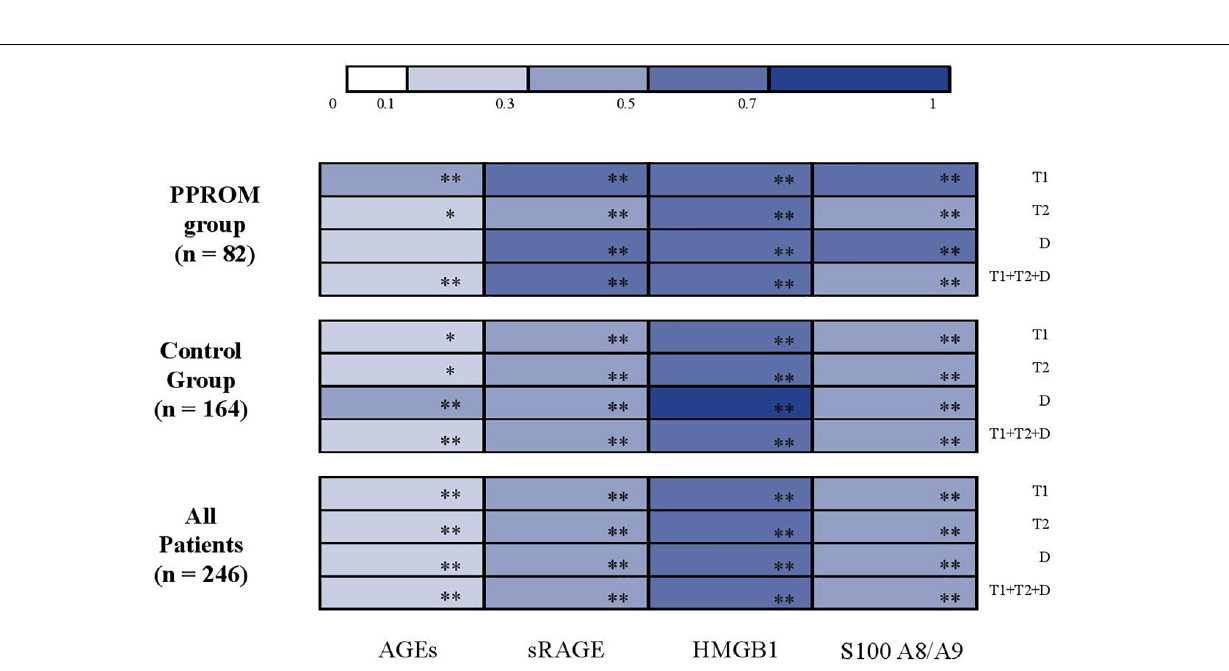
Frontiers in Physiology |